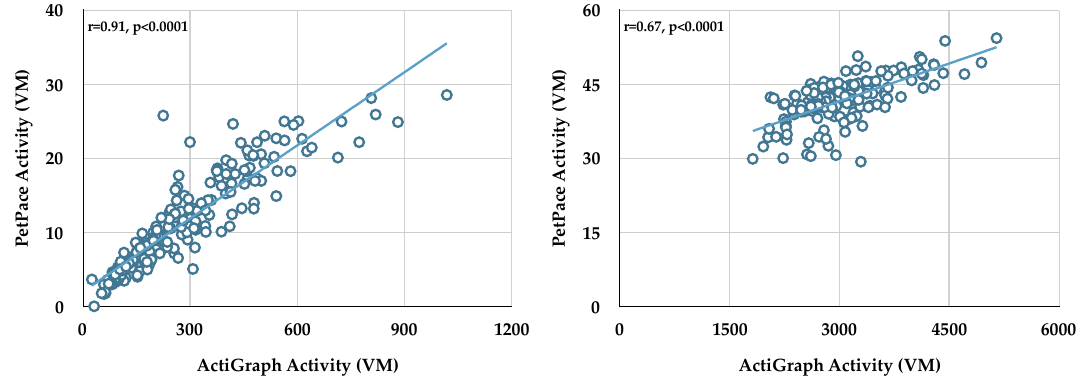
Figure 2. Linear relationship between ActiGraph activity (vector magnitude, VM) and PetPace activity (VM) during sedentary bouts ( left panel ) and light-moderate bouts ( right panel ) in Dog 6. Each bout, whether categorized by ActiLife as sedentary, light-moderate, or vigorous, had corresponding activity data, but not all bouts had pulse, respiration, and VVTI data. For pulse and VVTI, 84 ± 3% of sedentary and 25 ± 6% of light-moderate bouts had corresponding data (sedentary vs. light-moderate, p < 0.0001), respectively. For respiration, 81 ± 4% and 17 ± 5% of sedentary and light-moderate bouts had corresponding data ( p < 0.00001), respectively. The missing values may reflect (a) some bouts between 10–15 min duration may not have had corresponding PetPace data collected, and (b) interfering noises on the PetPace acoustic sensor such as panting.